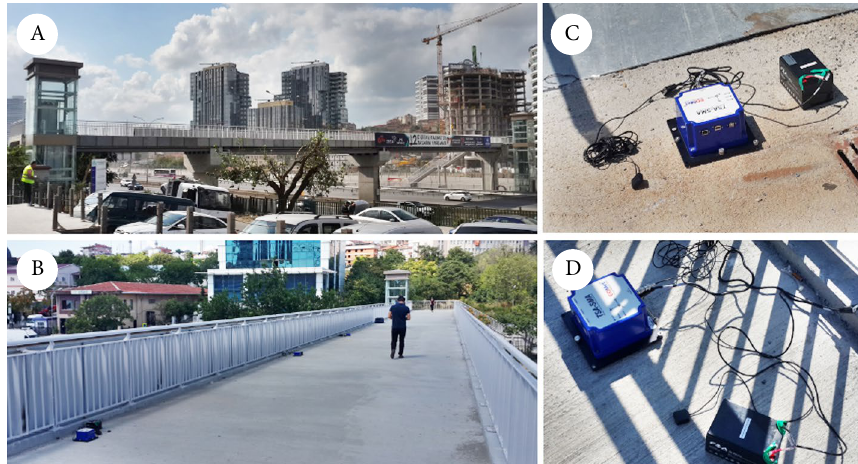
Figure 11. Modal testing (A, B: studied bridge, C: accelerometer on a pier, D: accelerometer on mid-span)